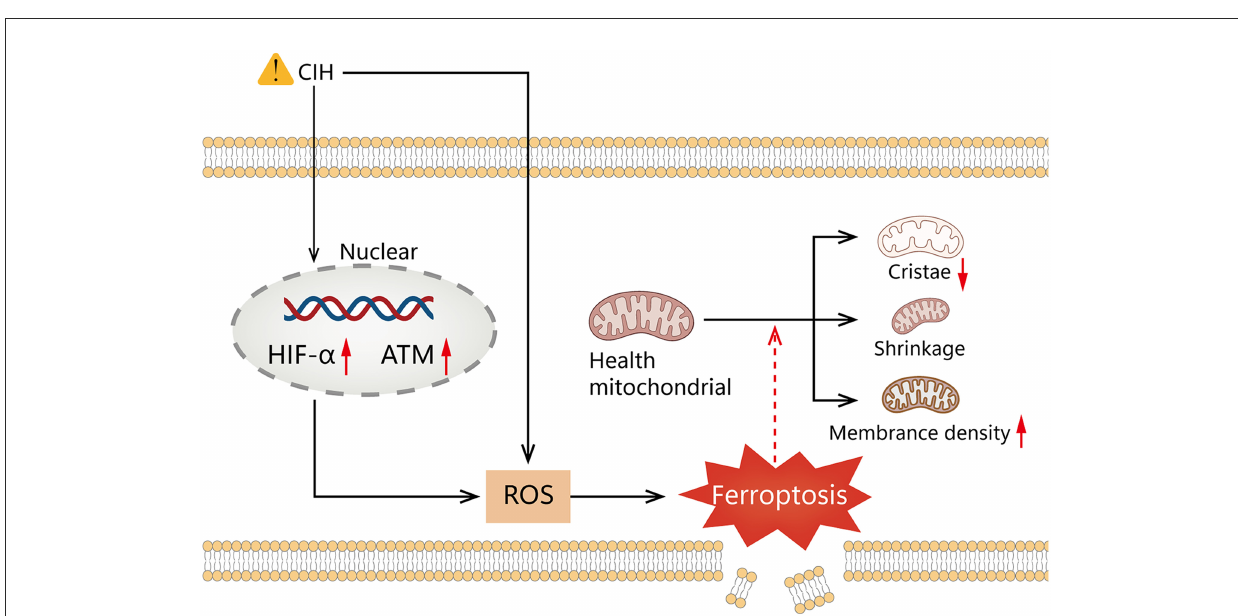
FIGURE9 Graphical summary illustrating elevated HIF1A and ATM expression, mediates ROS elevation by chronic intermittent hypoxia promotes ferroptosis.